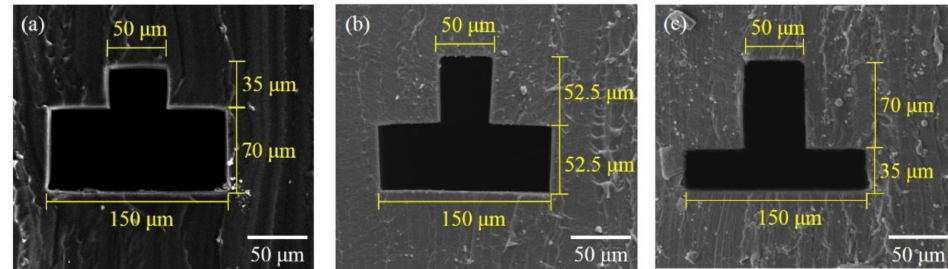
Figure 3. SEM images of microchannels with a T-shaped cross-section. ( a ) Type 1, ( b ) Type 2, ( c ) Type